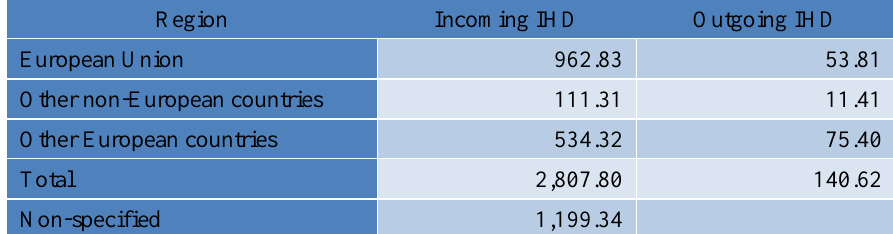
Table 1. Foreign direct investment in Kosovo by country of origin as of 31 March 2014 (million euro) (Central Bank of Kosovo,